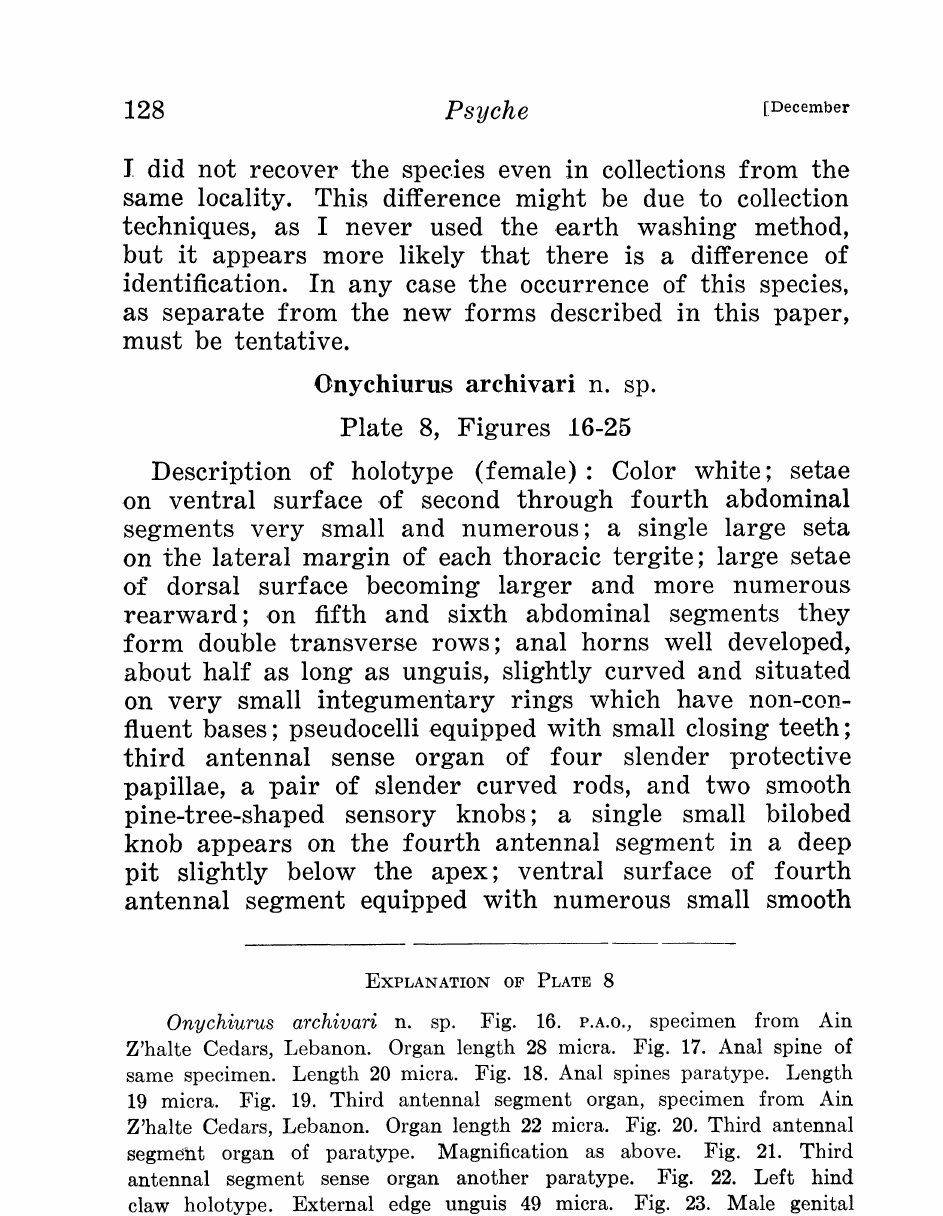
Fig. 16. P.A.O., specimen from Ain Z’halte Cedars, Lebanon. Organ length 28 micra. Fig. 17. Anal spine of same specimen. Length 20 micra. Fig. 18. Anal spines paratype. Length 19 micra. Fig. 19. Third antennal segment organ, specimen from Ain Z’halte Cedars, Lebanon. Organ length 22 micra. Fig. 20. Third antennal segmeut organ of paratype. Magnification as above. Fig. 21. Third antennal segment sense organ another paratype. Fig. 22. Left hind claw holotype. External edge unguis 49 micra. Fig. 23. Male genital plae paratype. Organ length 38 micra. Fig. 24. Dorsal surface of head .of paratype. Fig. 25. Right antennal base, specimen from Ain Z’halte ,edars,